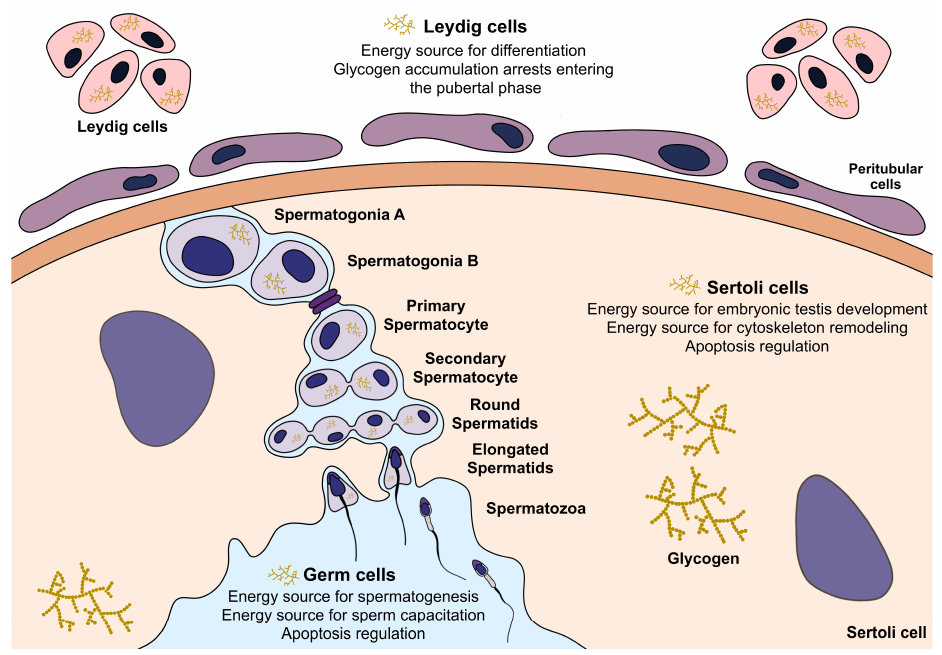
Figure 3. Illustration of effects of glycogen metabolism in testicular somatic and germ cells. In Sertoli cells, glycogen is hypothesised to be a source of energy for embryonic testis development and cytoskeleton remodelling, but also an apoptosis regulator. In other somatic cells, Leydig cells, glycogen metabolism is hypothesised to offer energy for differentiation, but its accumulation arrests their differentiation. Glycogen could also provide energy for spermatogenesis and capacitation and be an apoptosis regulator in germ cells.